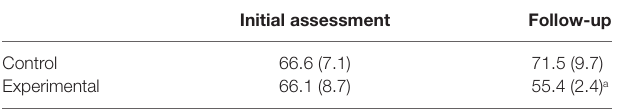
Table 5 | Mean (sD) PrOMis anger scores.